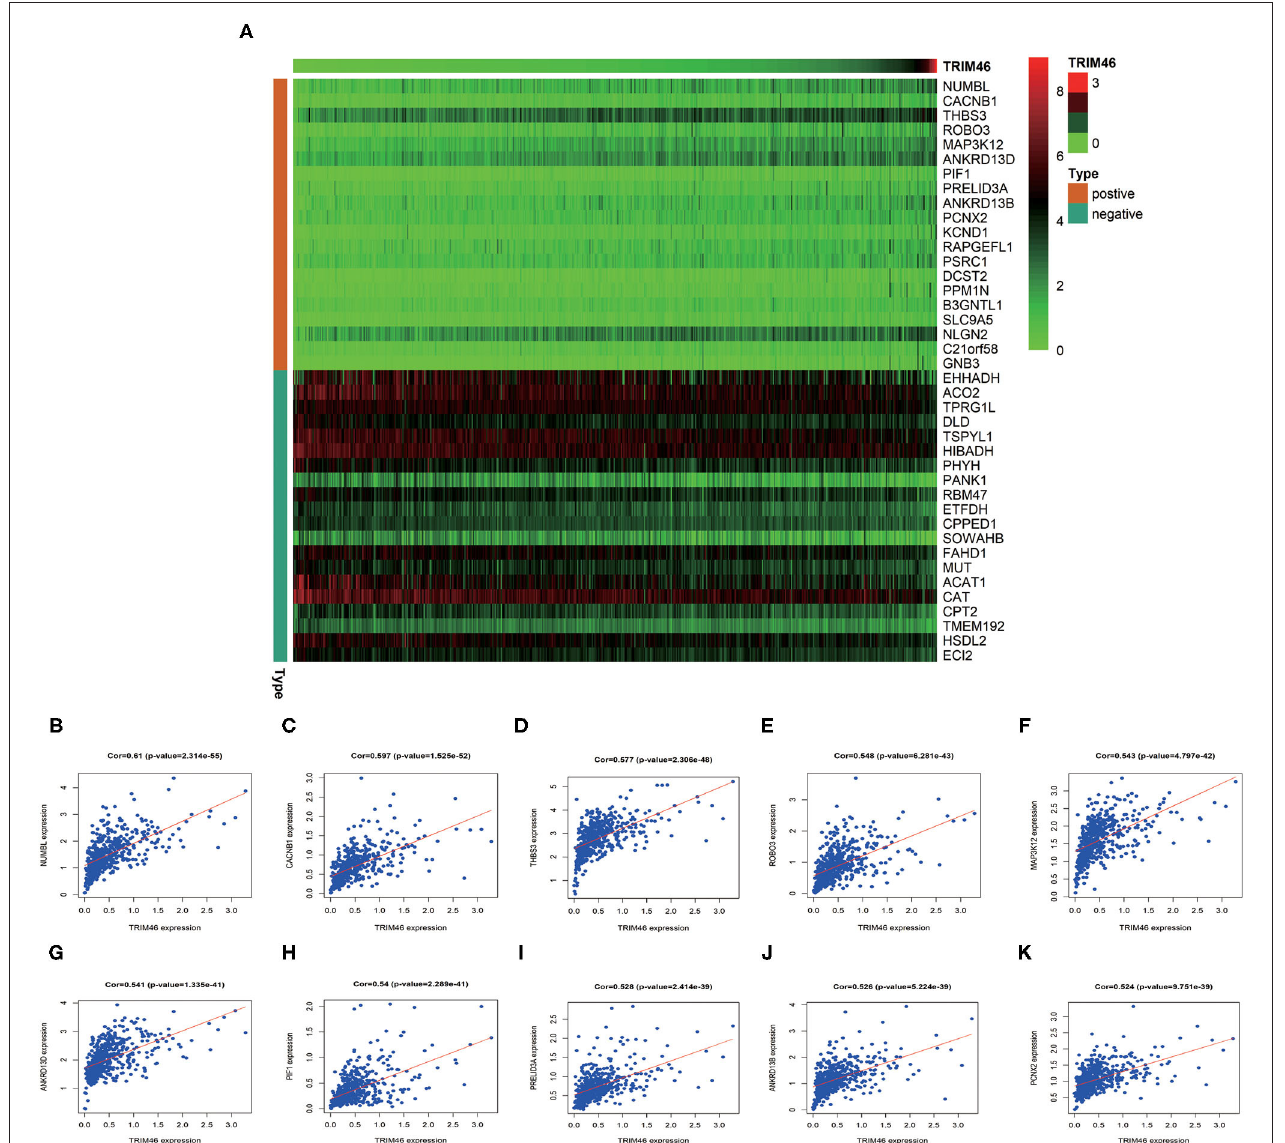
FIGURE 5 | Co-expression assays. (A) The top 20 genes related to TRIM46. (B–K) The association of TRIM46 with NUMBL, CACNB1, THBS3, ROBO3, MAP3K12, ANKRD13D, PIF1, PRELID3A, ANKRD13B, and